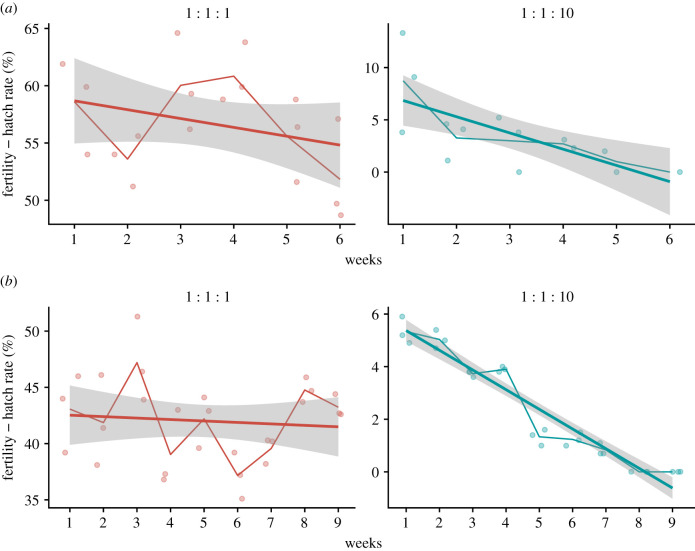
The cage suppression experiment. The Red-eye GSS (a) and the Red-eye GSS/Inv35 (b) were tested for their ability to suppress a target population in laboratory cage experiments by setting up three types of cages with three replicates each: the ‘1 : 1 : 0' fertile control cage (1 wild-type female: 1 wild-type male: 0 irradiated Red-eye GSS males), the ‘1 : 1 : 1' suppression cage and the ‘1 : 1 : 10' suppression cage. Only the two later are presented (‘1 : 1 : 1' and ‘1 : 1 : 10’) since the data from the fertile control cage have been used to assess the baseline fertility used for the calculations. Releases of irradiated Red-eye GSS were performed twice a week for six weeks, and releases of Red-eye GSS/Inv35 males were performed twice a week for a period of nine weeks. The thicker straight line represents the generalized model with the grey-shaded area as the standard error, while the jagged thinner line represents the mean of each week; the points indicate the observed data. (Online version in colour.)